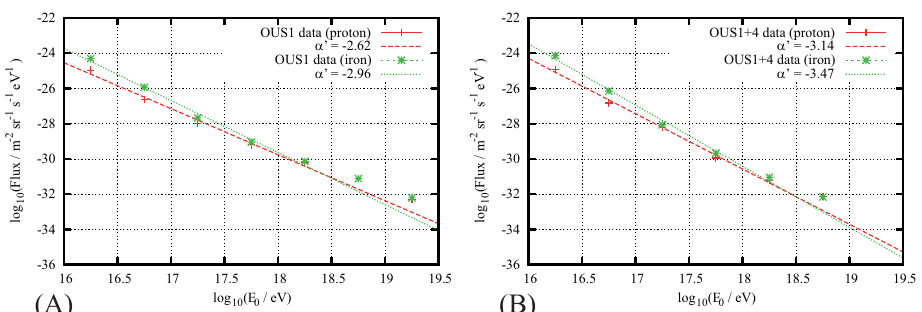
Figure 5. The data spectrum assumed to be proton and iron primaries, respectively, in the OUS1 (A), and in the OUS1+4 (B). Symbols of ( + ) and ( ∗ ) indicate observed data. Lines show the result of the least square fittings. OUS1. also, α proton and α iron are equal to − 3 . 12 ± 0 . 13 and − 3 . 52 ± 0 . 17, respectively, in the same primary energy region in